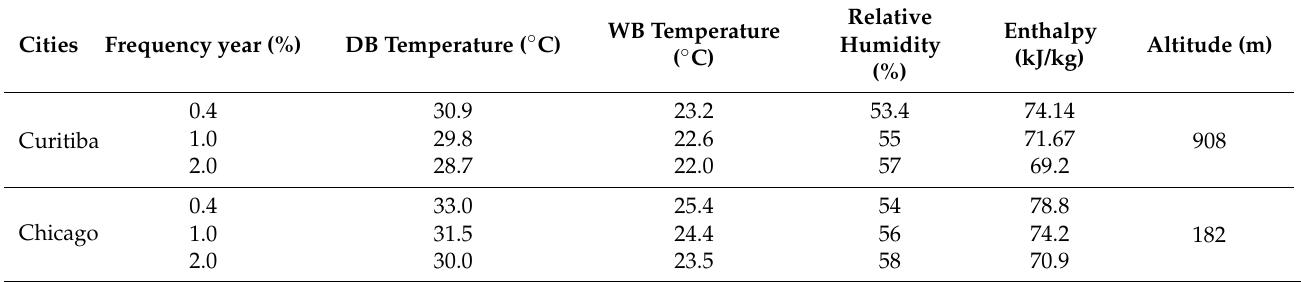
Table 2. Data for the cities of Curitiba and Chicago (adapted from